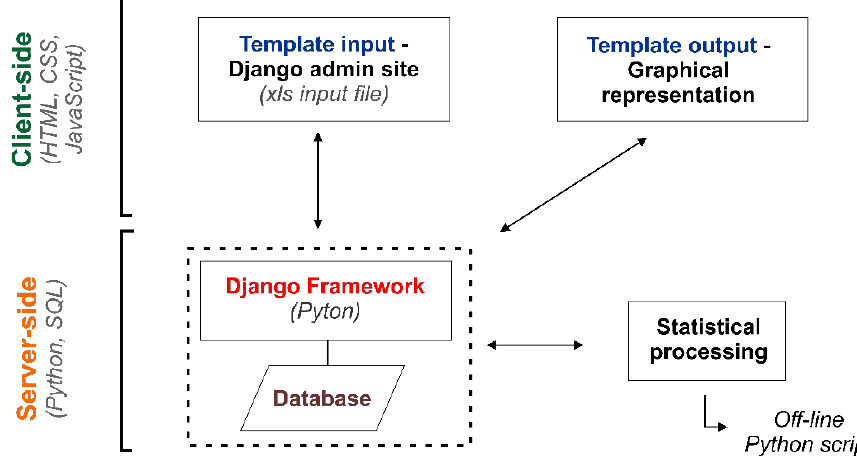
Figure 1. A schematic representation of the SLONIP platform architecture .